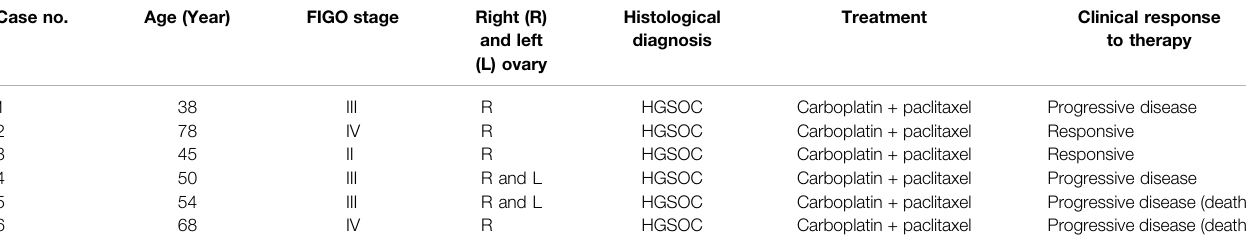
TABLE 1 | Clinicopathological characteristics of six ovarian cancer patients that were treated with neoadjuvant chemotherapy. Case no. FIGO stage Right (R)